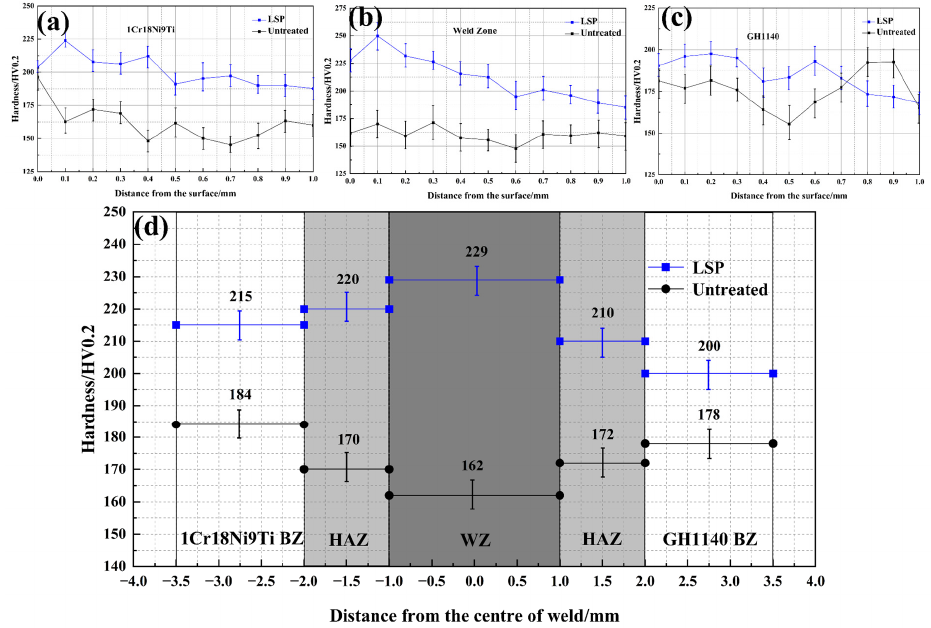
Figure 6. ( a ) Microhardness distribution along the depth direction in the 1Cr18Ni9Ti region before and after laser shock peening; ( b ) microhardness distribution along the depth direction in the GH1140 region before and after laser shock peening; ( c ) microhardness distribution along the depth direction in the weld region before and after laser shock peening; ( d ) surface hardness distribution of combustion liner weld.